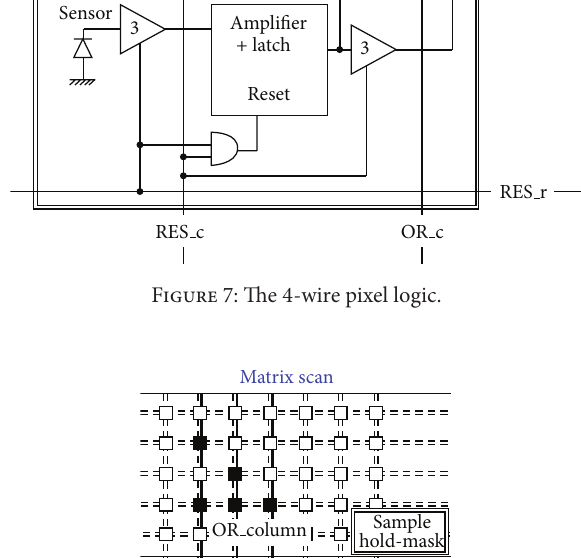
Figure 8: Columns and rows of the hits.